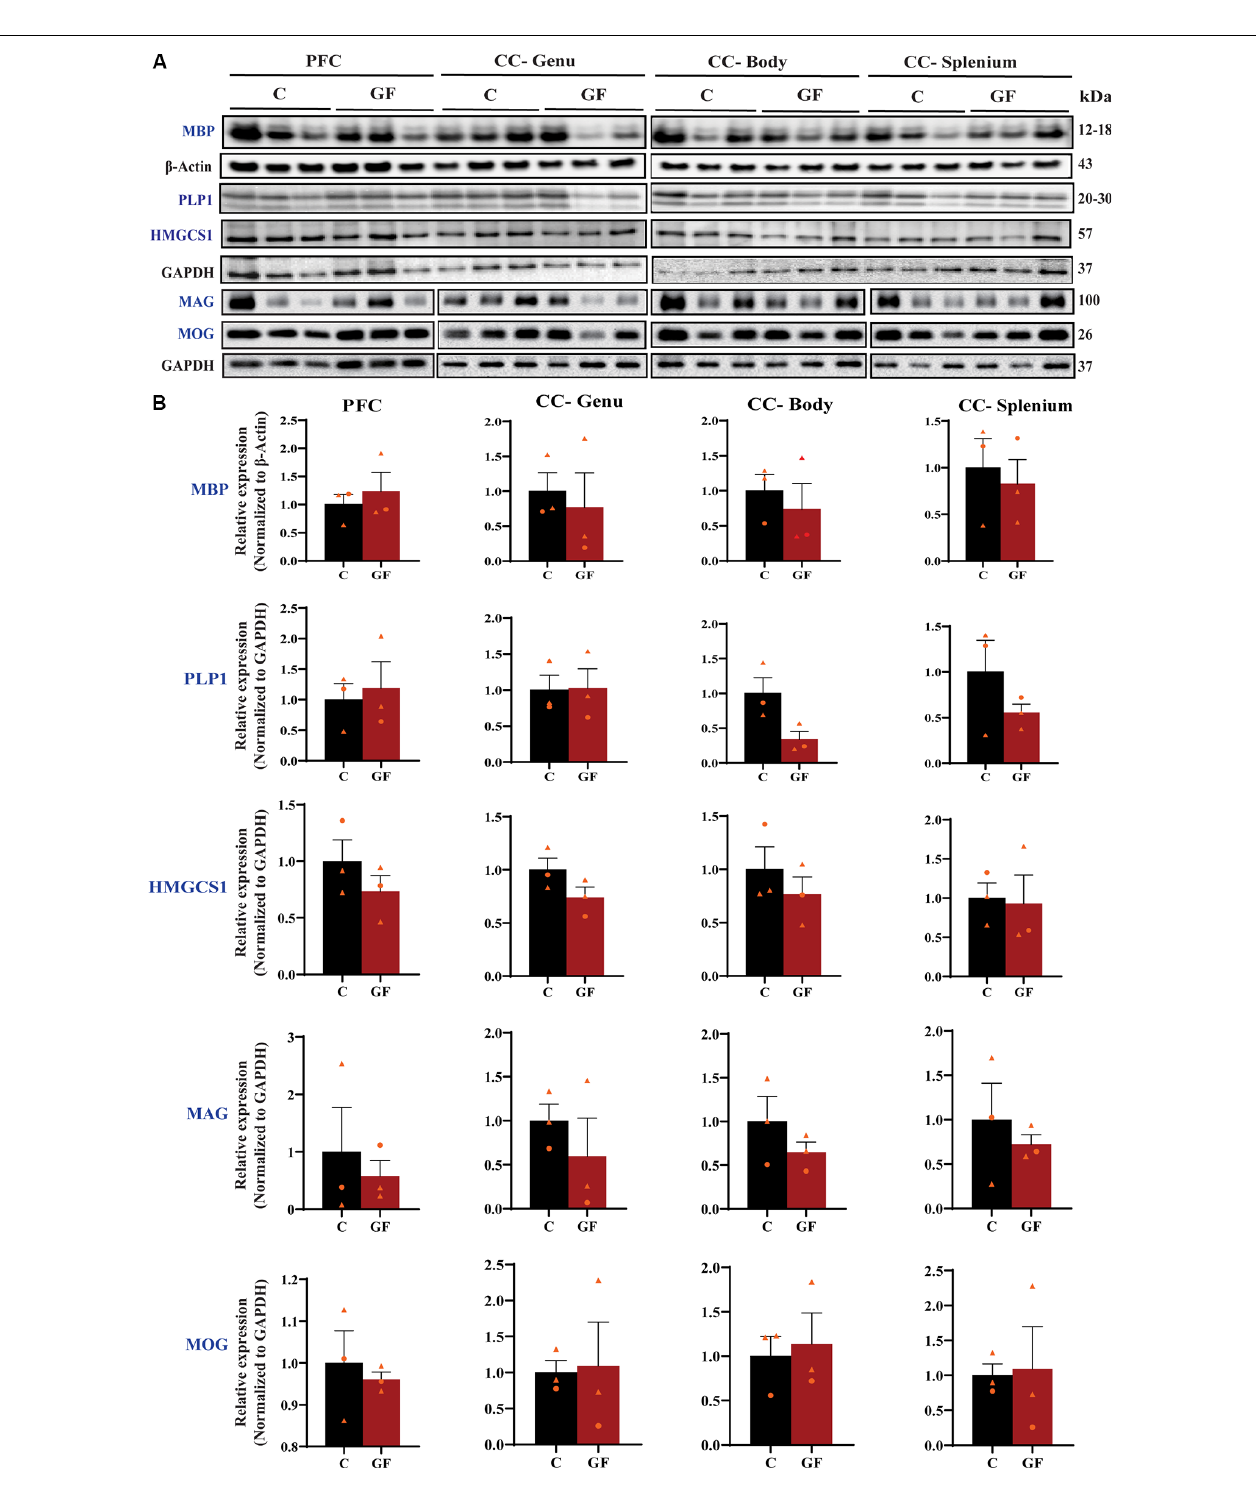
FIGURE 3 | Quantitative assessment of myelin-related protein densities at 16 days of age. (A) Western blot analysis of MBP, PLP1, HMGCS1, MAG, and MOG protein (blue font) expression in tissue isolated from the PFCWM, CC-Genu, CC-Body, and CC-Splenium of control (C) and germ-free (GF) animals at P16. Loading controls: β -Actin for MBP, GAPDH for PLP1, HMGCS1, MAG, and MOG. (B) Quantification of protein expression normalized to respective loading controls. Individual male and female animals are marked by orange triangles and circles, respectively. Data expressed as mean ± SEM, n = 3 animals/group. No significant differences determined by unpaired student’s t -test or Mann-Whitney U test. PLP1, proteolipid protein; HMGCS1, Hydroxymethylglutaryl-CoA synthase; MAG, myelin-associated glycoprotein; MOG, myelin oligodendrocyte glycoprotein.